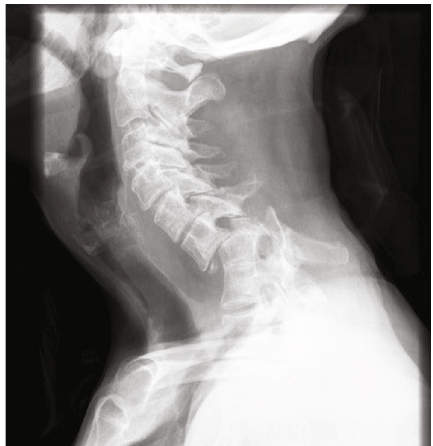
Figure 1: Preoperative X-rays (lateral